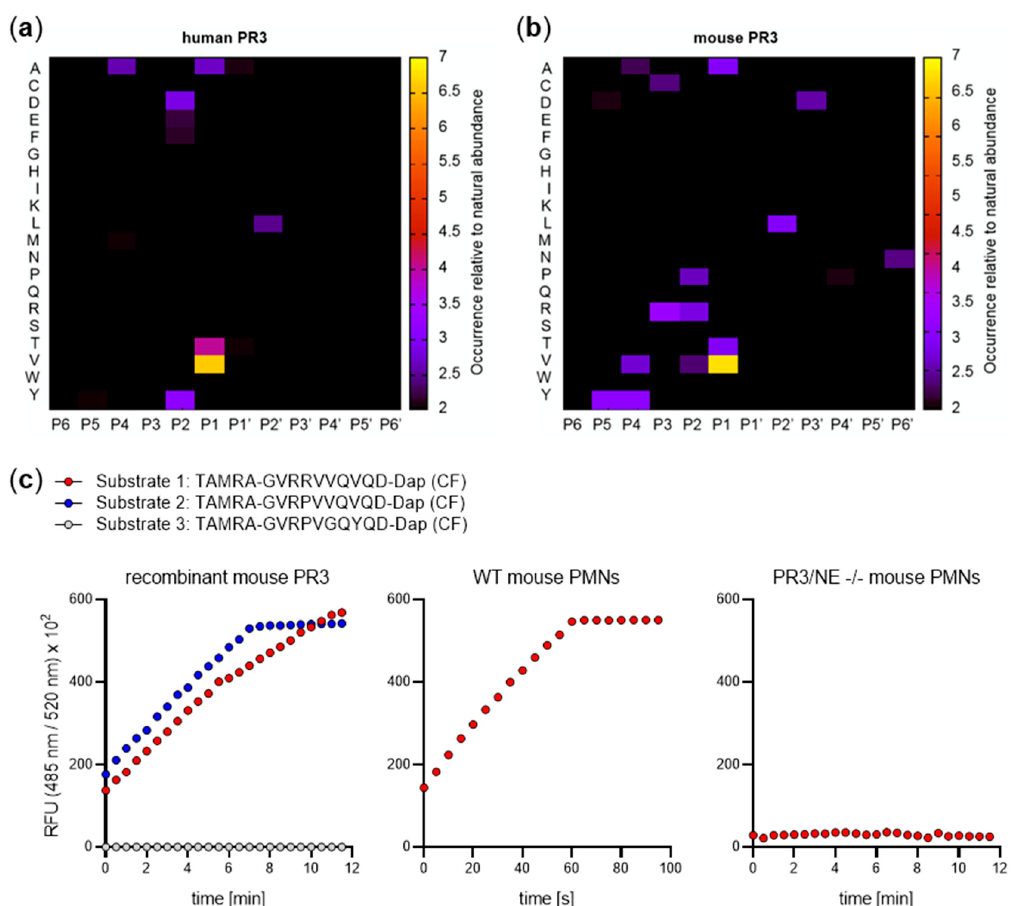
Figure 5. Profiling of the proteinase 3 (PR3) cleavage site reveals the cleavage site specificity of human ( a ) and mouse ( b ) PR3 after V, A, or T at position P1; the peptide libraries were generated with GluC; ( c ) Differences of the mouse PR3 cleavage sites in P1 and P2 position were analyzed by activity assays with 50 nM mPR3 using specific fluorogenic TAMRA substrates ( λ ex = 485 nm λ ex = 520 nm) (10 µM) in 50 mM Tris, 150 mM NaCl, 0.01% Tween-20 (pH 7.4).